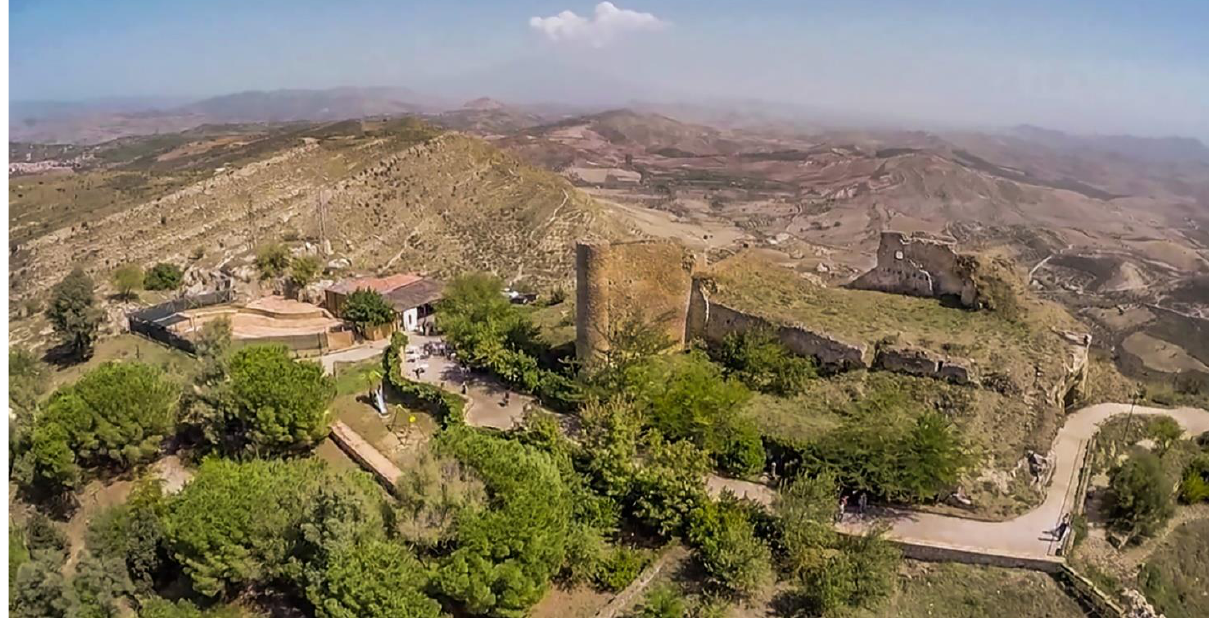
Figure 1. The ruins of Assoro castle,